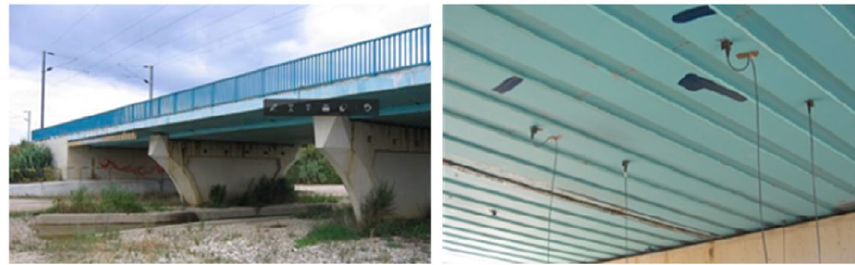
Fig. 27 The bridge dynamic weighing